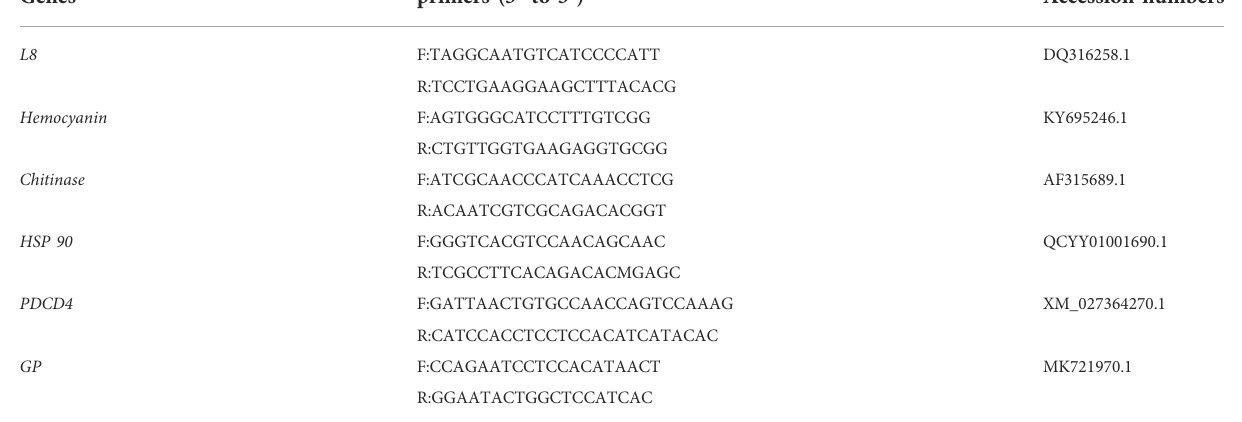
TABLE 1 Primer sequence of the selected